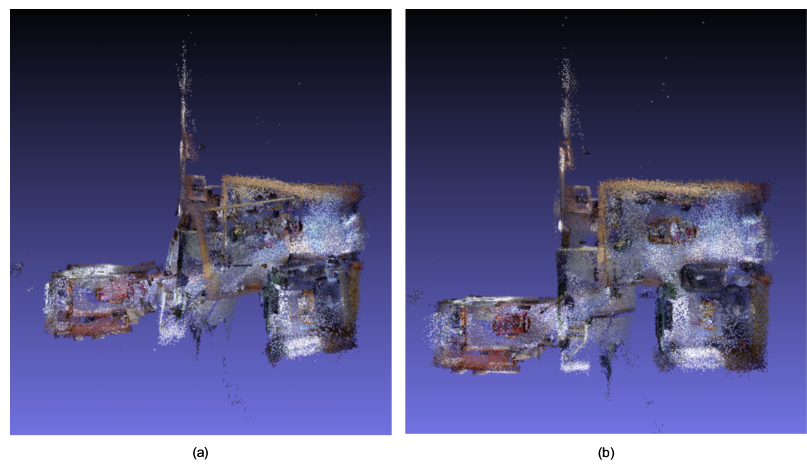
Figure 11. Test result using a typical house environment. ( a ) Traditional BA [35] suffers from the noisy data source and produces a rough 3D model; ( b ) the proposed method produced a 3D model fitting to the structure of the